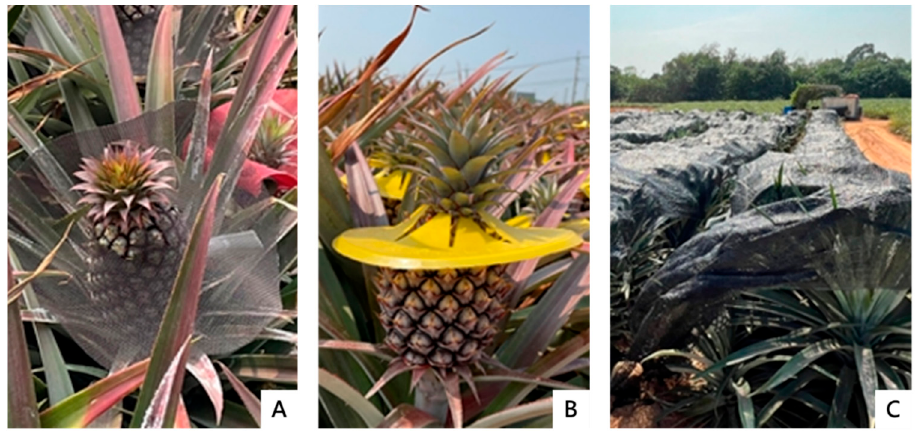
Figure 2. The phenological growth stages of pineapple in the study area.